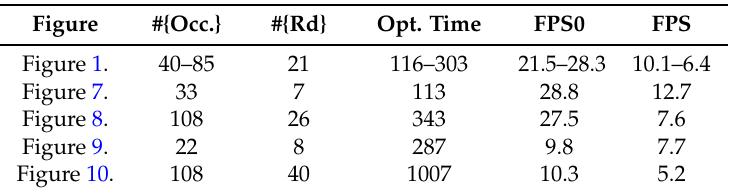
Figure 13. Occlusion-free views with different weights: ( a ) original perspective view; ( b ) occlusion-free view with predefined weights; ( c , d ) occlusion-free views with different ω t values; ( e , f ) occlusion-free views with different ω s values; and ( g , h ) occlusion-free views with different ω rd values. 4.4. Weight Adjustment In our method, there are three weight parameters that are closely related to the deformation, namely, the road scale factor ω rd , the building displacement weight ω t and the scaling weight ω s = (ω sx , ω sy , ω sz ). Although we have provided the recommended values, users might want to alter these parameters themselves. In most 3D urban environments, we set ω sx = ω sy = ω, ω sz = 2ω, while ω rd , ω t